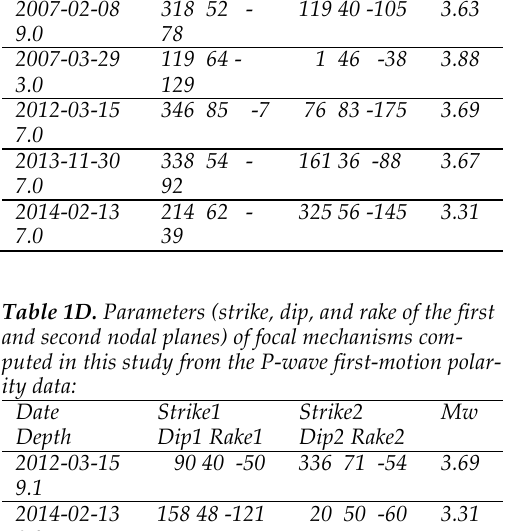
Table 1B. Parameters (strike, dip, and rake of the first and second nodal planes) of moment tensor available European - Mediterranean RCMT Catalogue [Pon- drelli et al., 2006; http://www.bo.ingv.it/RCMT/]: